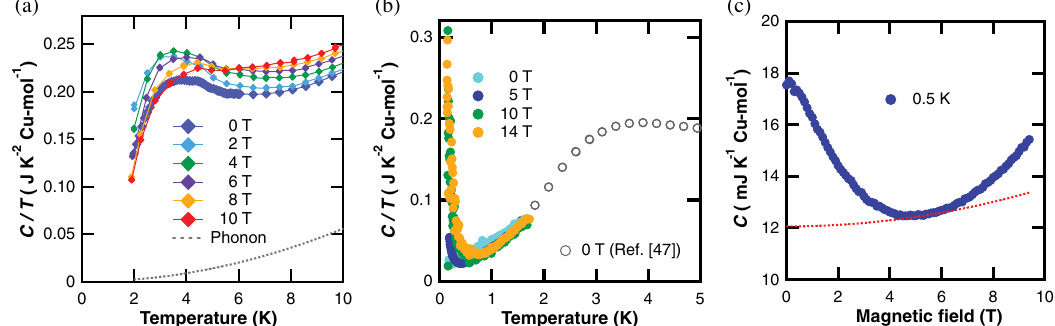
FIG. 8. (a) Temperature dependence of the specific heat divided by the temperature ( C=T ) measured in PPMS. The measurements are done for the same set of multiple single crystals used in Ref. [47]. The peak around 4 K corresponds to the AFM transition. The dashed =T estimated by a fitting for the data at high temperatures (see Supplemental Material [51] for line shows the phonon contribution C ph details). (b) Temperature dependence of C=T of another set of multiple single crystals measured in DR. The zero-field data from the previous report [47] are also shown by open circles. (b) Magnetic field dependence of C at 0.5 K. The red dotted line shows an estimation of the magnetic field dependence of the nuclear Schottky specific heat ( C ) at 0.5 K. The data of C are shifted to compare ncl ncl the amount of the field increase.